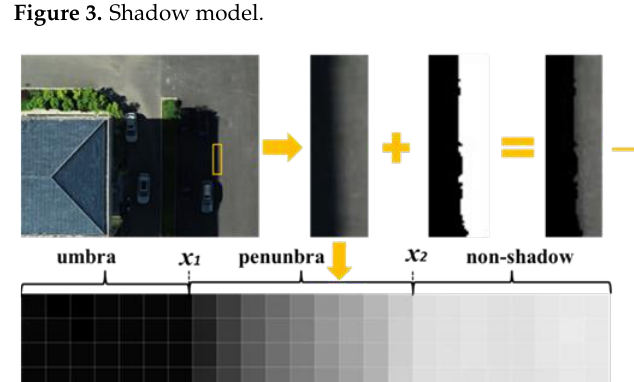
Figure 3. Shadow model.